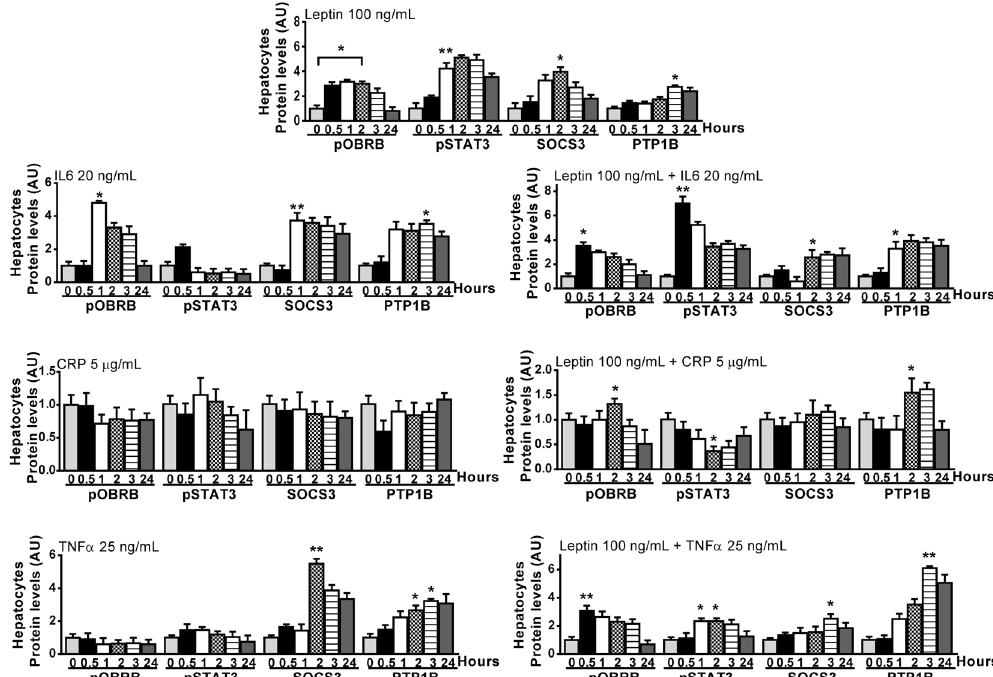
Figure 8. Effects of TNF- α , IL-6, and CRP on leptin signaling. Cultured HepG2 cells were treated with 100 ng/mL leptin in the absence or presence of 20 ng/mL IL-6, 25 ng/mL TNF- α , or 5 µ g/mL C-reactive protein for 30 minutes to 24 hours. The effects of these factors were assessed by measuring tyrosine phosphorylation of ObRb and Stat3 and protein expression of SOCS3 and PTP1B, using appropriated antibodies. Protein expression in unstimulated hepatocytes was assumed to be 1. Results are given as mean ± S.D. * p < 0.05; ** p < 0.01 vs . unstimulated hepatocytes. Representative immunoblots are shown in Supplementary Figure